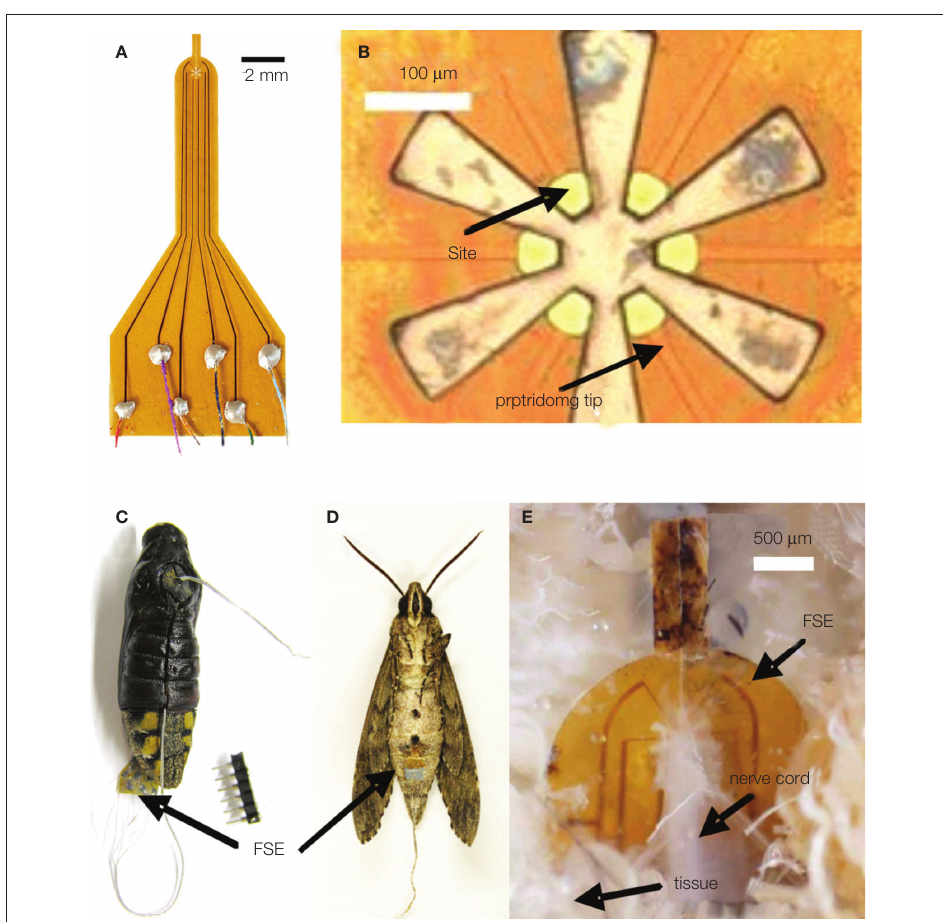
FIguRe 3 | A moth hybrid system. (A) Image of the flexible split-ring electrode (FSE) with color-coded wire connections; (B) close-up image of the FSE at the split-ring region; (C) image of a pupa with inserted FSE; (D) enclosed adult moth with FSE inserted at the pupal stage; (e) image of dissected adult moth showing the growth of connective tissue around the FSE. Reproduced from Tsang et al. (2010a).